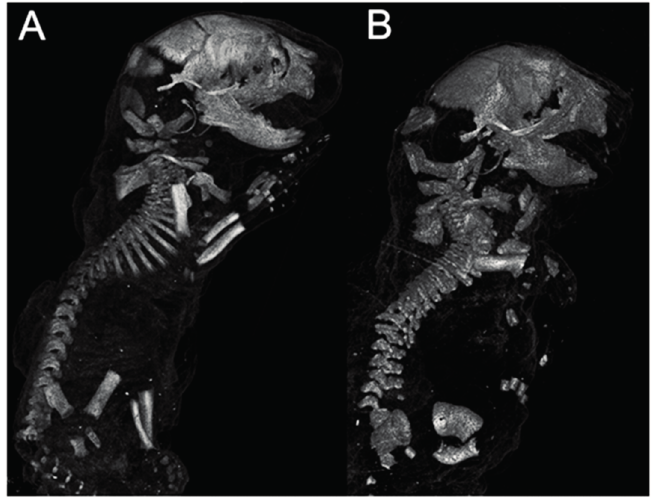
Figure 1. Micro-CT images of whole body for WT and Col11a1-deficient littermates at embryonic day 17.5 (e17.5d). ( A ) WT mouse; and ( B ) Col11a1-deficient mouse.